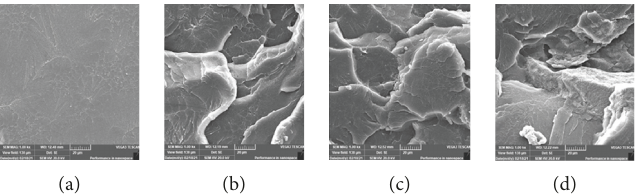
Figure 2: (a)–(d) Representative SEM images of group I specimens. (a) Unmodified 0%NDs, (b) 0.05% NDs-modified specimens, (c) 0.25% NDs-modified specimens, and (d) 0.5% NDs-modified specimens.